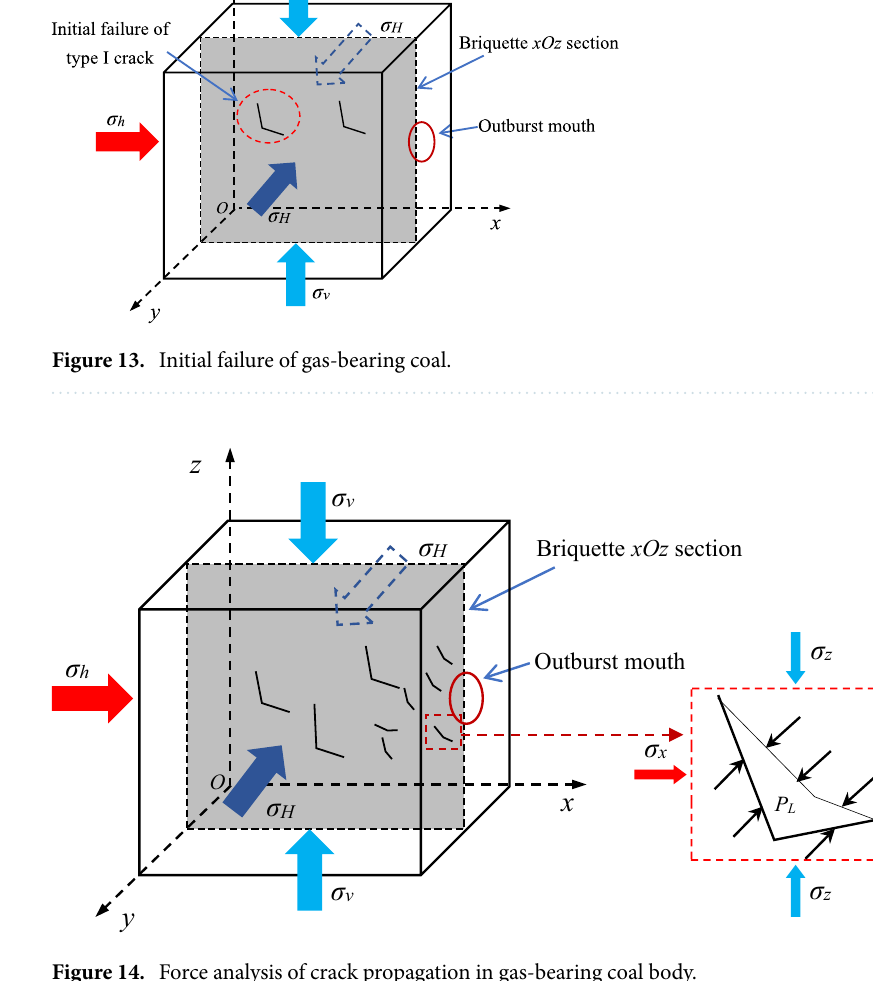
Figure 14. Force analysis of crack propagation in gas-bearing coal